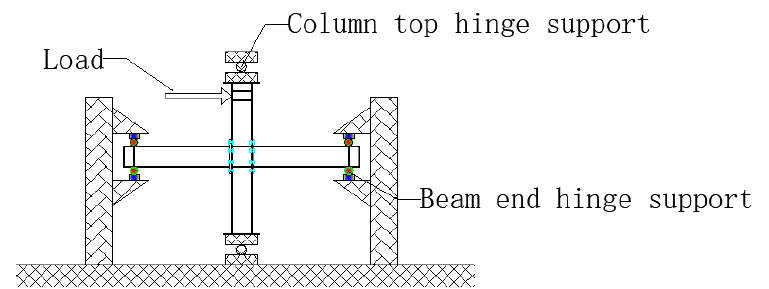
Figure 3. Boundary conditions of the model. Table 5. Material properties of two steels.